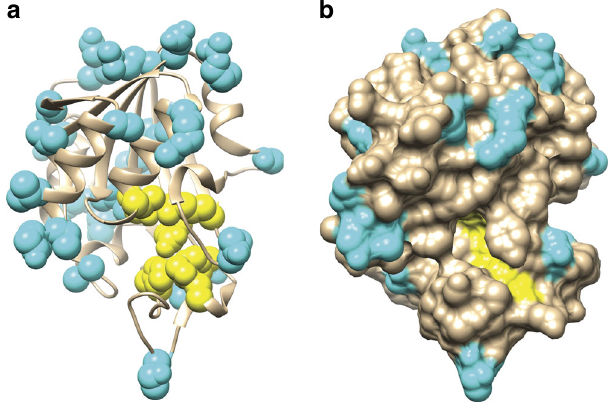
Fig. 6 Amino acid substitutions to which no substitution resulted in pyrazinamide resistance ( n = 29) map to surface exposed regions of PncA. a Ribbon diagram of the PncA crystal structure 48 . b Surface representation of the PncA crystal structure 48 . Cyan represent amino acids to which no substitution resulted in pyrazinamide resistance. Yellow are active site and iron coordinating amino